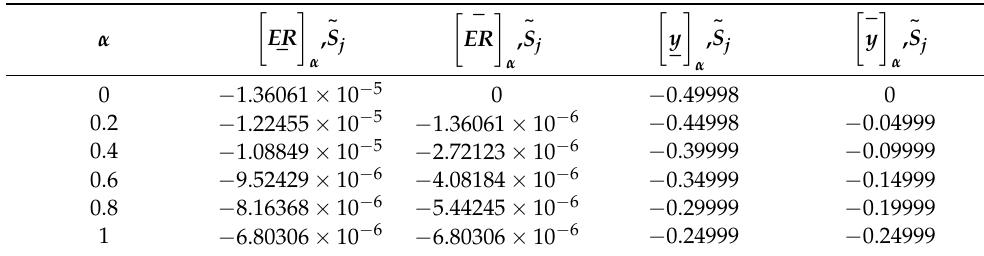
Table 1. The approximate solutions and errors for Equation (31) using the third-order FF-OHAM at x = 0.5 for all α ∈ [ 0,1 ] .